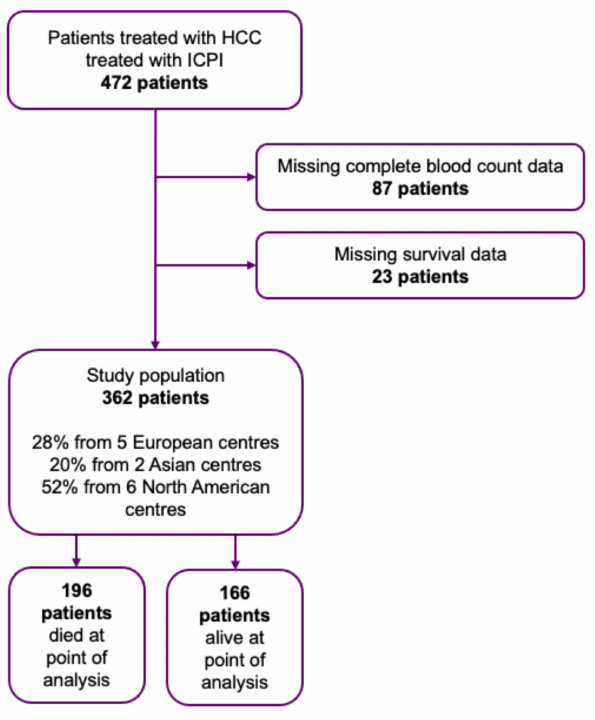
Figure 1. Study population after excluding patients not eligible for the final